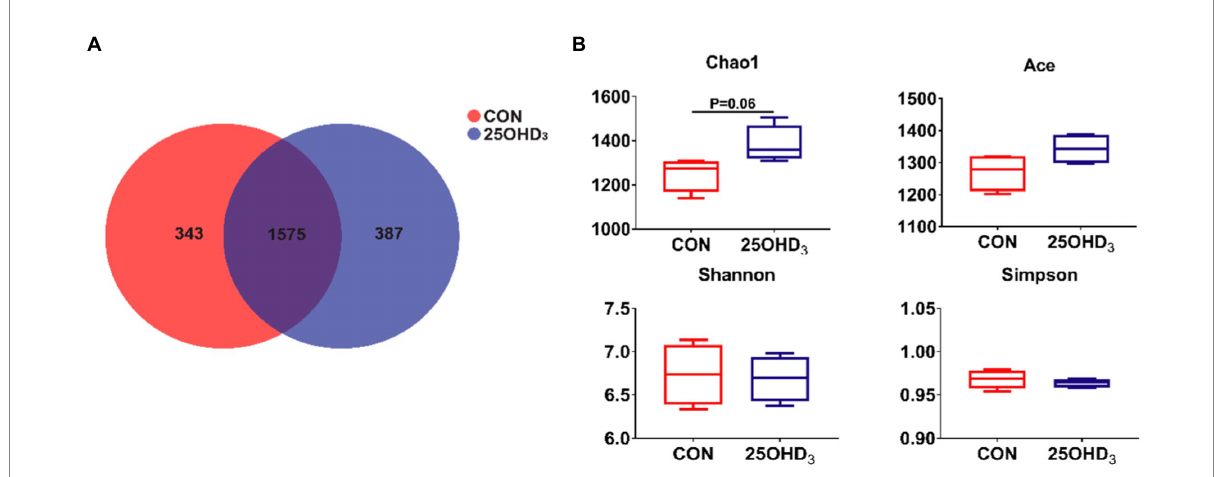
FIGURE 5 The colonic microbiota richness and diversity. (A) OTU Venn. (B) Comparison of a-diversity indices between the two treatments. Values are shown as the means ± SEM, n =